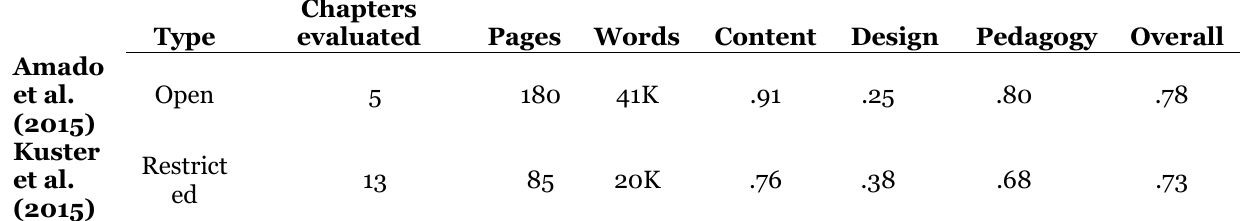
Deep Evaluation Results for the Top Two